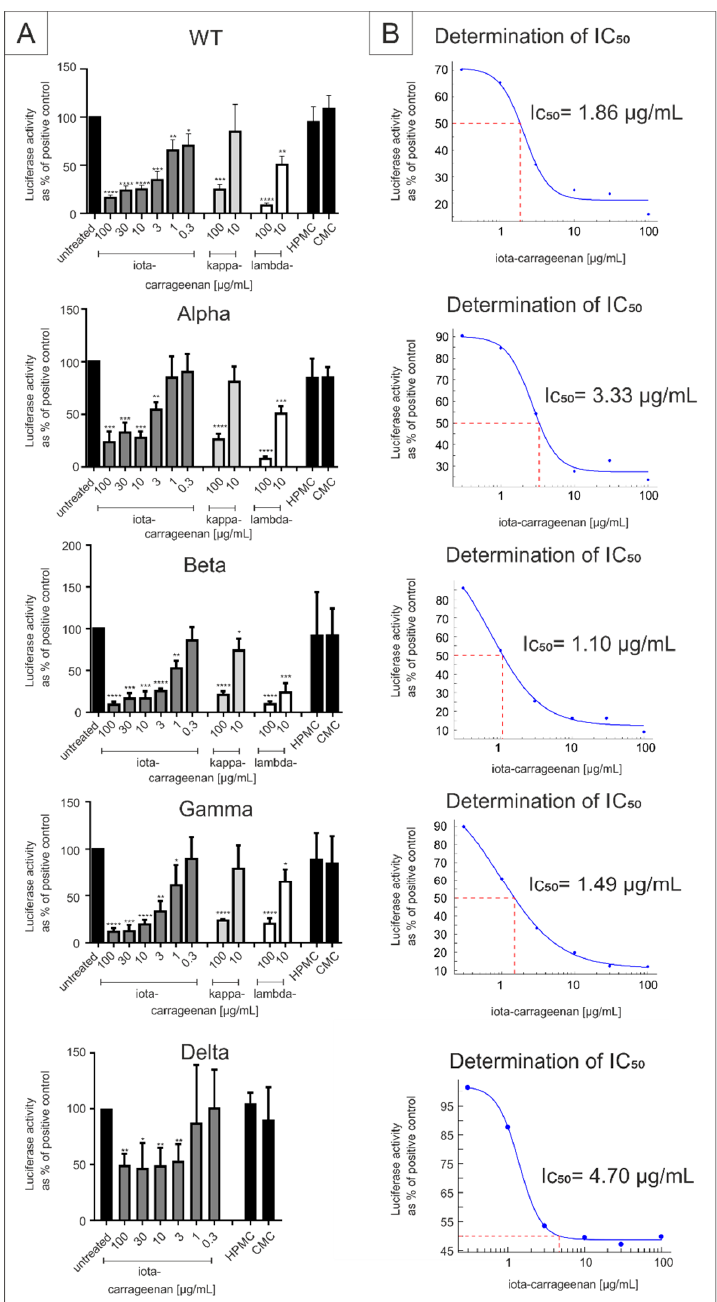
Figure 1. Effect of iota-, kappa- and lambda-carrageenan on SARS-CoV-2 spike driven entry. ( A ) Luciferase activity following infection of ACE2-HEK293 with SSPL particles normalized to untreated infected cells which served as positive control (100% infection control; y -axis). 100, 30, 10, 3, 1, 0.3 µ g/mL iota-carrageenan, 100 and 10 µ g/mL kappa- and lambda-carrageenan, and 100 µ g/mL non-sulfated polymers (hydroxypropylmethylcellulose (HPMC), carboxymethylcellulose (CMC)) were incubated with the SSPL for 30 min before infection. The efficiency of infection in cell lysates was determined by measuring the luciferase activity 48 h post infection. ( B ) Determination of IC50 values using Excel XLfit version 5.5.0.5. The data represent means of quadruplicates ± standard deviation (* p < 0.5, ** p < 0.01, *** p < 0.001, **** p < 0.0001 using a one sample t test, where each value is compared to the untreated control). Abbr.: iota-carrageenan, kappa-carrageenan, lambda-carrageenan, CMC and